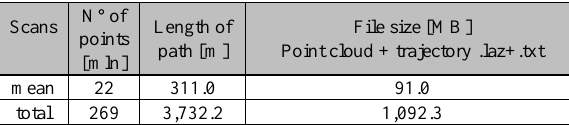
Table 10. MMS processed scans